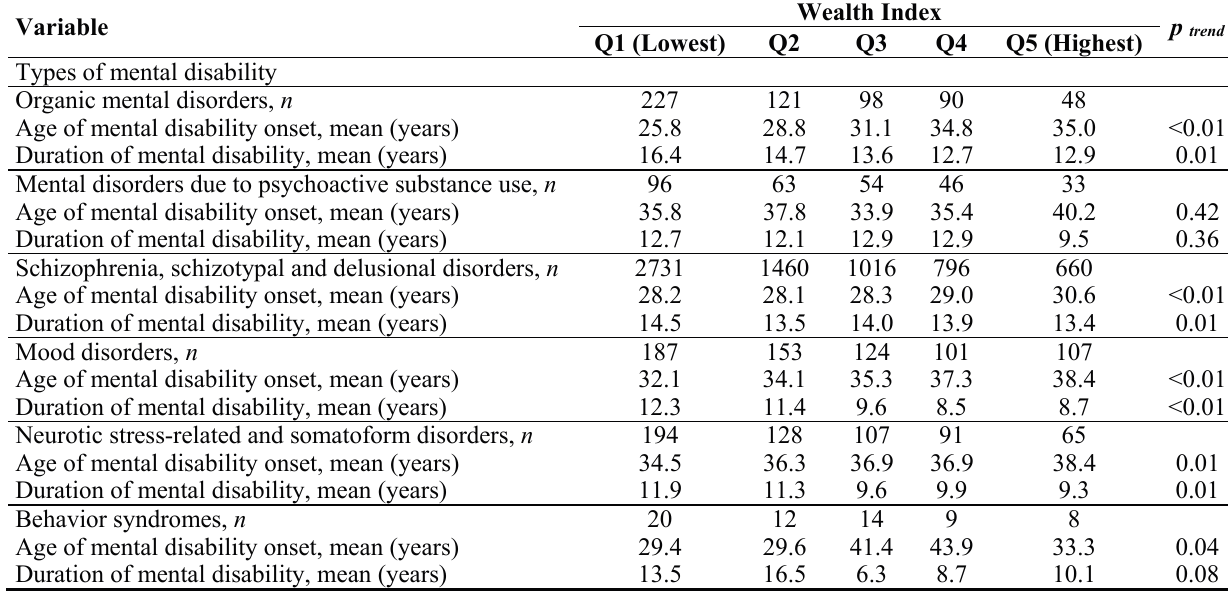
Table 4. Characteristics of different types of mental disability by wealth index quintiles a